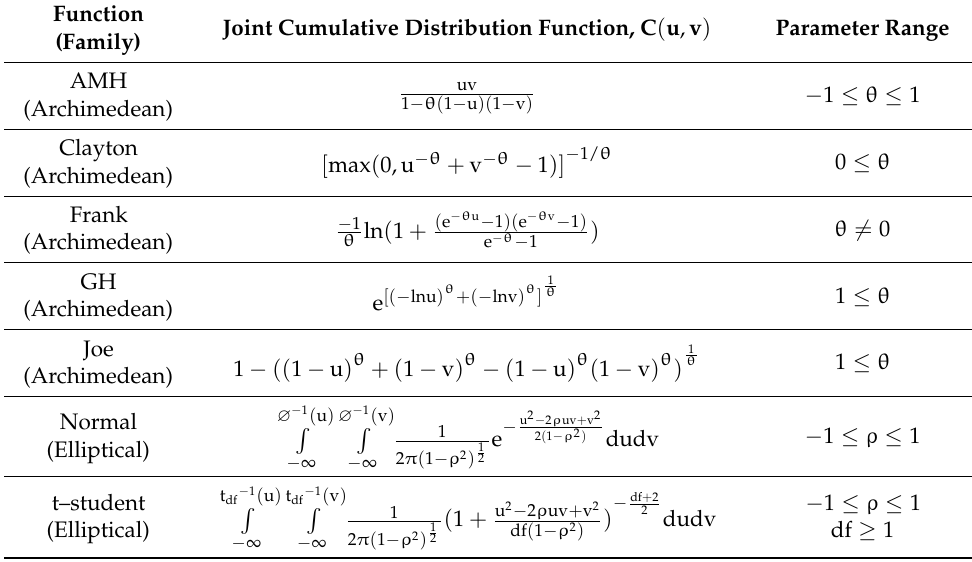
Table 1. Equations of Copula functions. Here u and ν are two dependent univariate variables, df is the degree of freedom, θ and ρ are Copula dependence parameters, ∅ is the CDF of standard univariate Gaussian distribution, and t df is the t–student distribution function. AMH and GH refer to the Ali–Mikhail–Haq and Gumbel–Hougaard distributions,